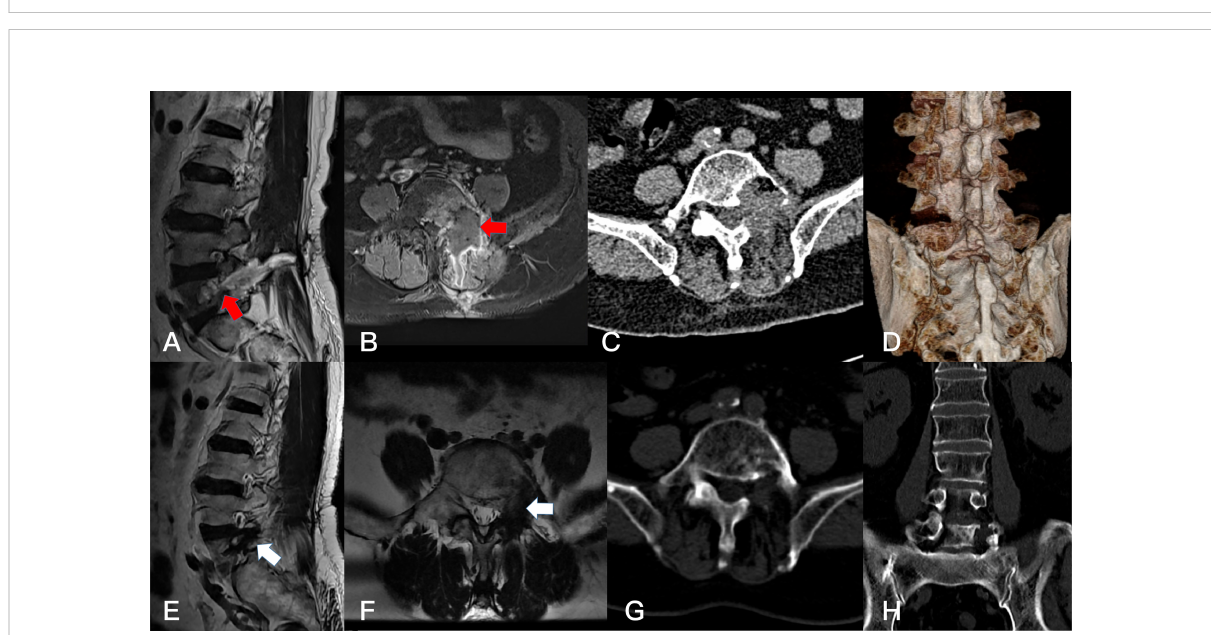
FIGURE 7 Postoperative T1-weighted enhanced MRI on sagittal (A) plane, and axial (B) palne, and the axial (C) and 3D-CT (D) scan. Resection of the dumbbell acute lymphocytic leukoma (B cell) could not be identi fi ed after 1 months (arrows). Postoperative T1-weighted enhanced MRI on sagittal (E) plane, and axial (F) palne, the CT scan of the axial (G) plane and coronal (H) plane after 2 years, showing the resection of the dumbbell tumor could not be identi fi ed